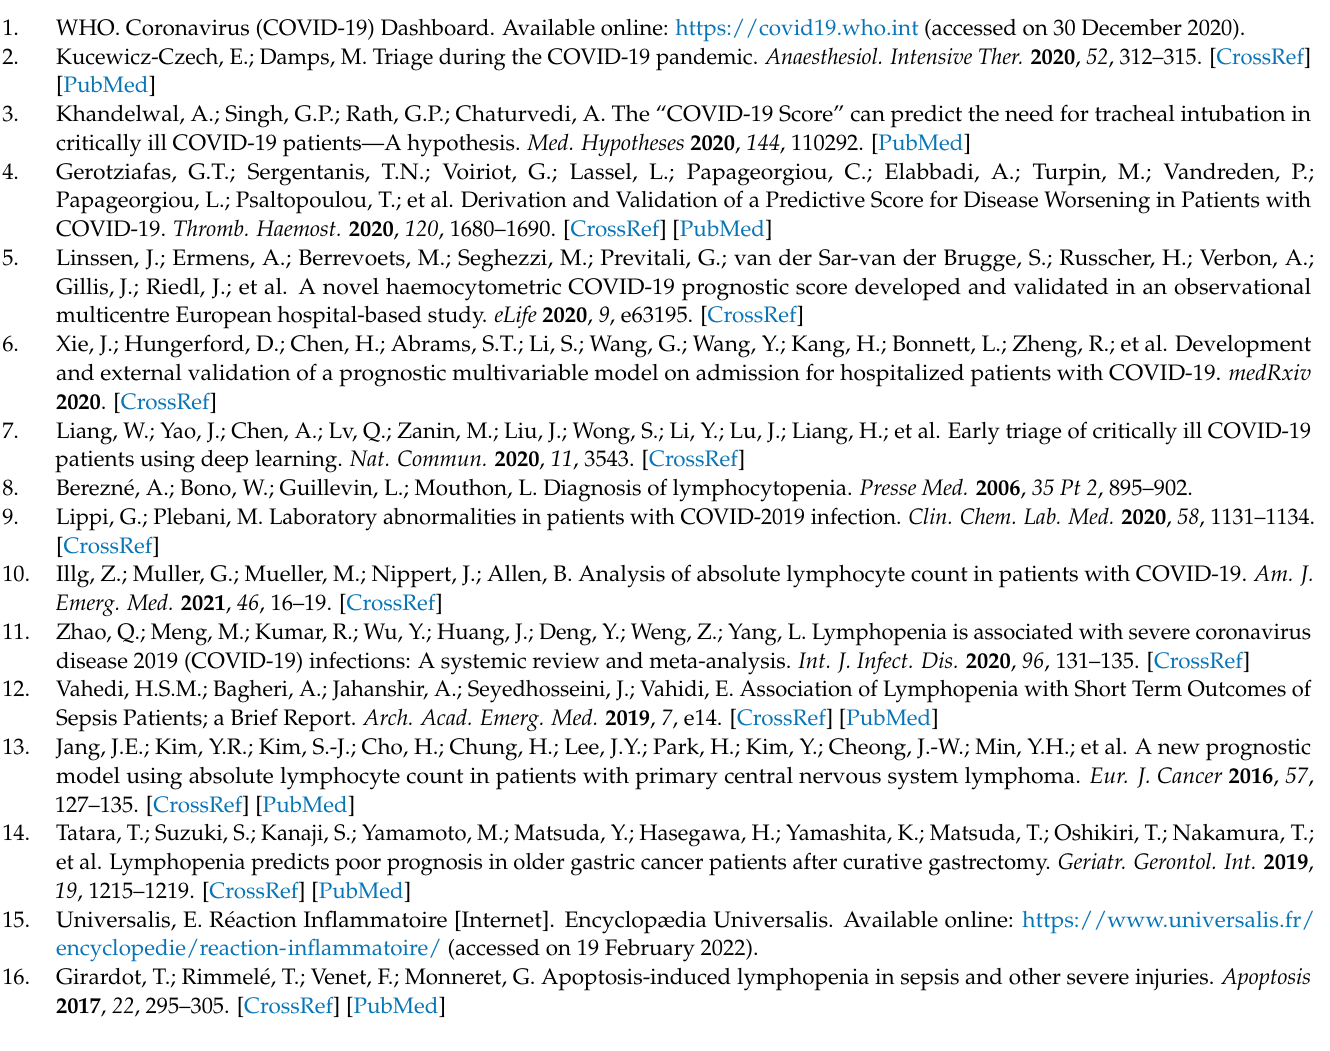
selection. Table S1. Prognostic value of lymphocytes and early variation of lymphocyte according age or gender to predict severity of disease. Table S2. Prognostic value of lymphocytes and early variation of lymphocyte according age or gender to predict